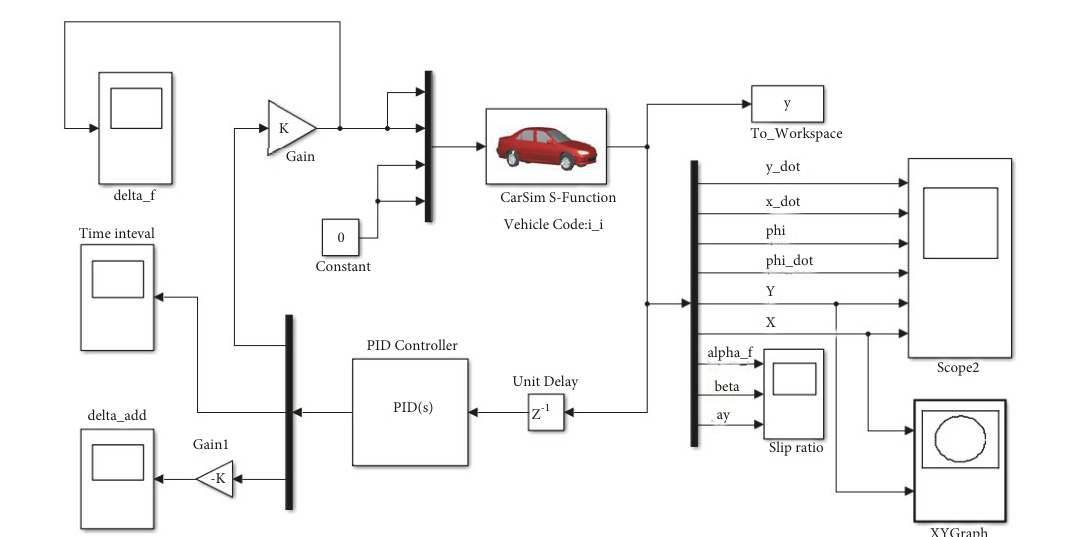
Figure 5: Joint simulation block diagram of PID control system with track tracking.